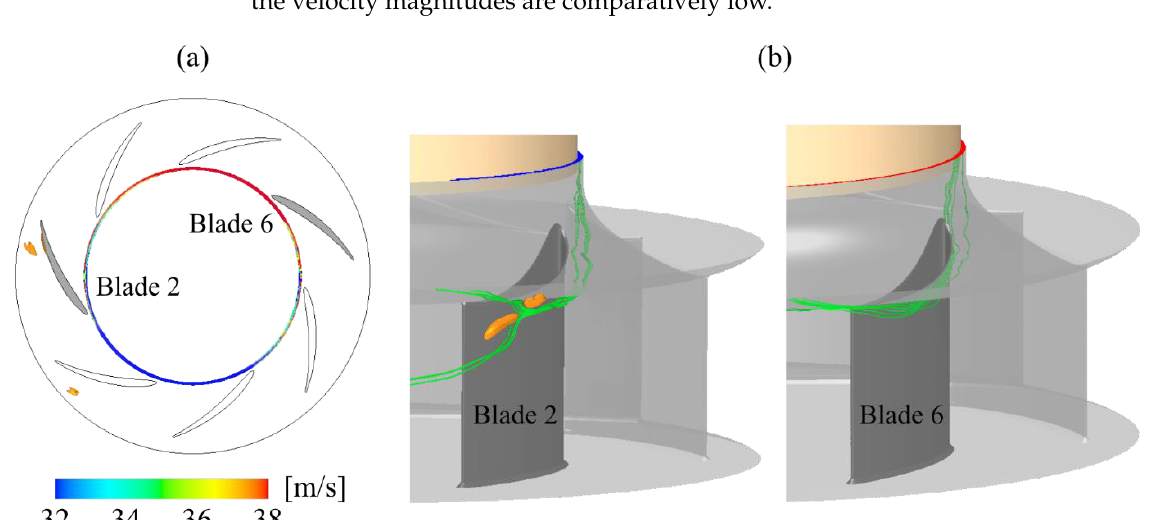
Figure 9. Iso-surface of p = 340 Pa colored in orange, and contours of ( a ) the velocity magnitudes at the entry of the gap. ( b ) Streamlines from the gap at Blades 2 and 6, and contours of the velocity magnitudes at the entry of the gap.